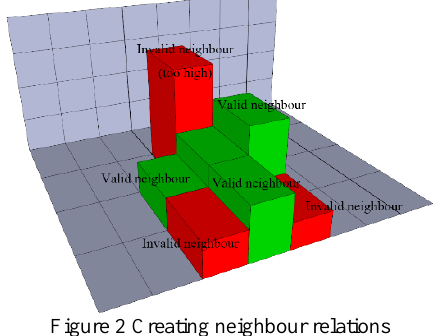
Figure 2 Creating neighbour